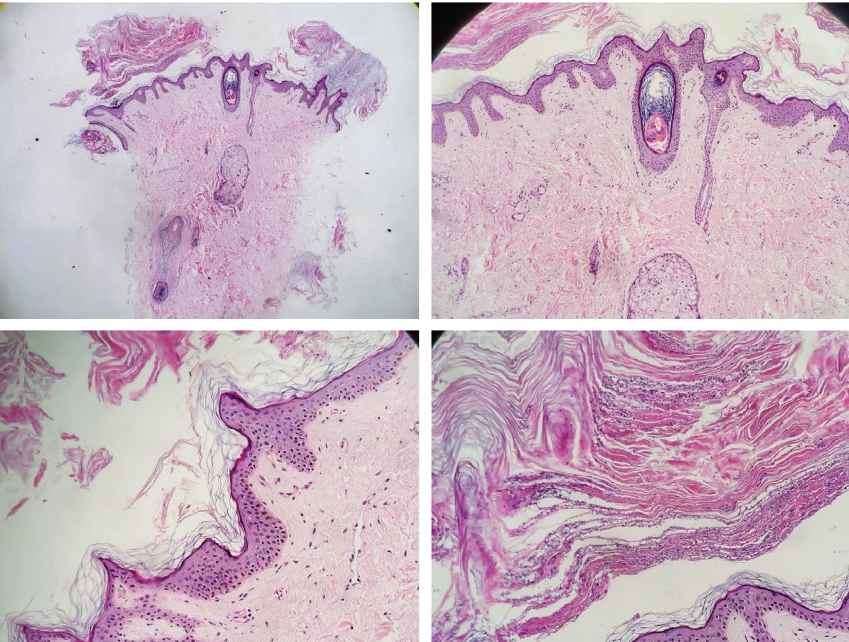
Figure 2: A skin biopsy showing marked hyperkeratosis with papillomatosis in the epidermis and numerous fungal organisms (yeasts) in the corneal layer. A very scant chronic perivascular infammatory infltrate was noted in the dermis with edema and fbrosis.